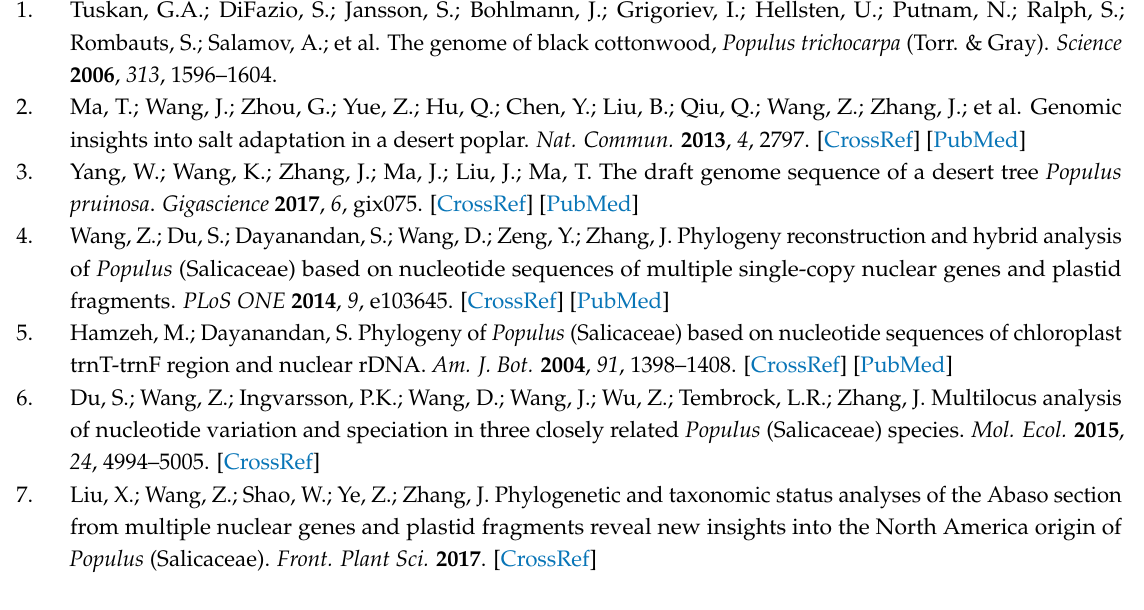
Table S1. GO annotation of shared orthologues in eight Salicaceae species, Table S2. Main geograhoical distribution of seven Populus , Figure S1. GO classes of shared orthologues in eight Salicaceae species, File S1. Sequences of 1835 shared orthologues in eight Salicaceae species, File S2. Sequences of resistance genes in genus Populus . Author Contributions: Conceptualization, Y.-j.Z.; analysis, Y.-j.Z. and C.-z.H.; validation, Y.C. and